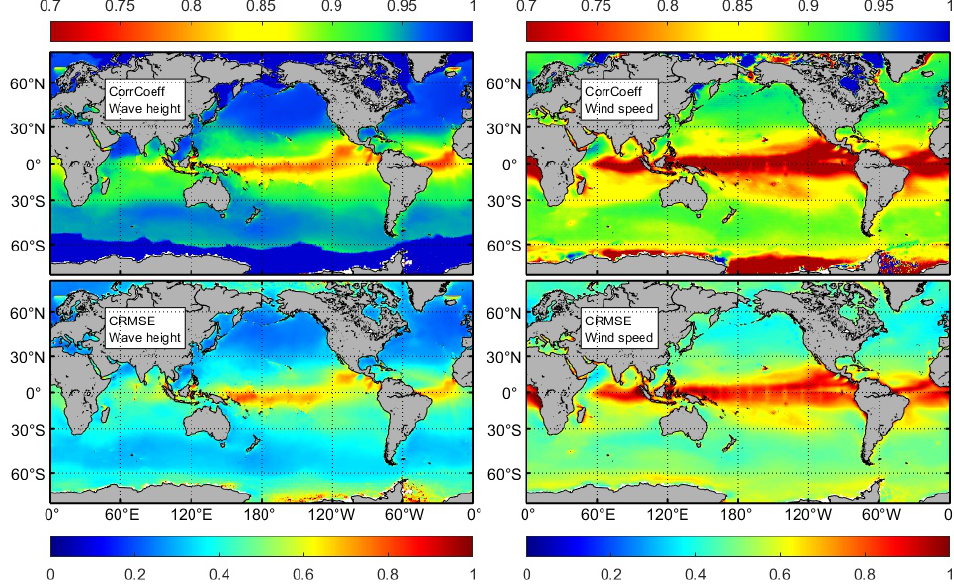
Figure 12. Mean annual variability of CorrCoeff, CRMSE, (from top to bottom ) between the two reanalyses ( left : significant wave height, right : wind